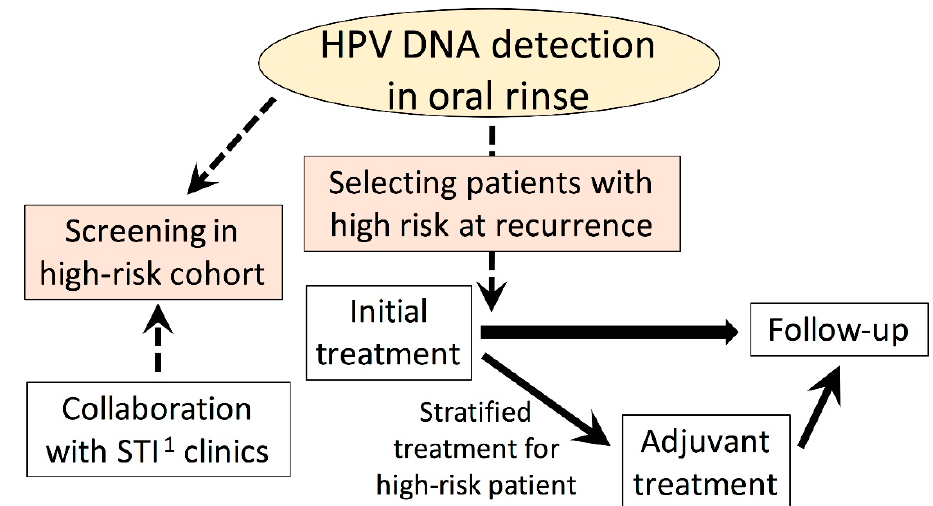
Figure 2. Future perspectives on utilizing HPV DNA detection in oral rinses in clinical settings. 1 STI, sexually transmitted infection. Modified from [47] with permission by the Society of Oto-Rhino-Laryngology, Tokyo.